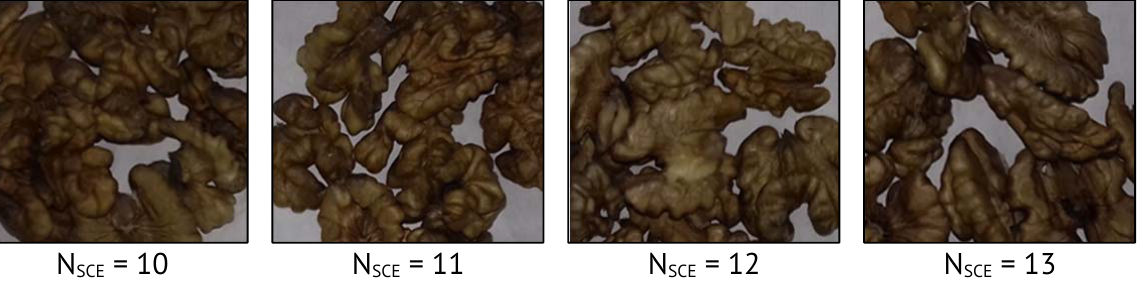
Figure 2. The external aspect of the walnuts kernels after extraction under the “step climb experience”